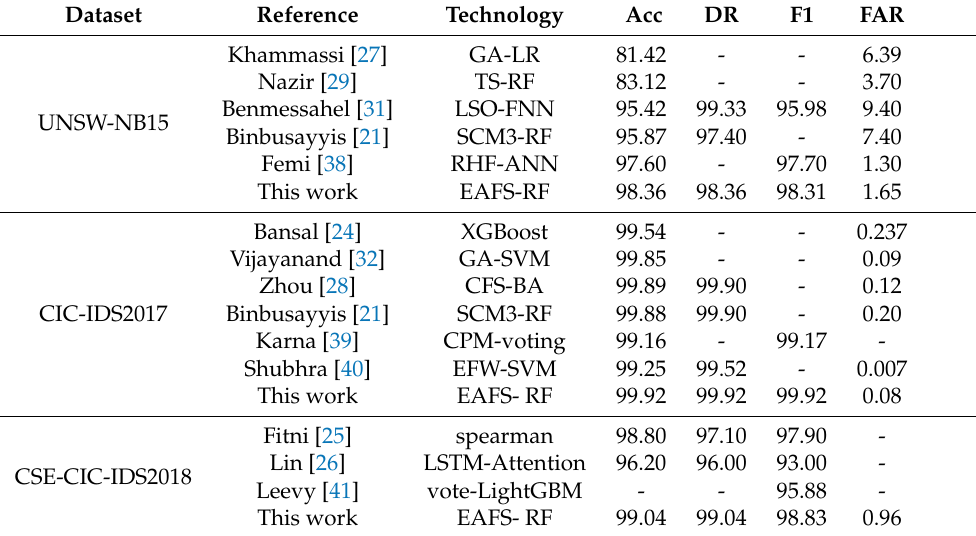
Table 3. Comparison of results on multiple datasets with the latest(%).